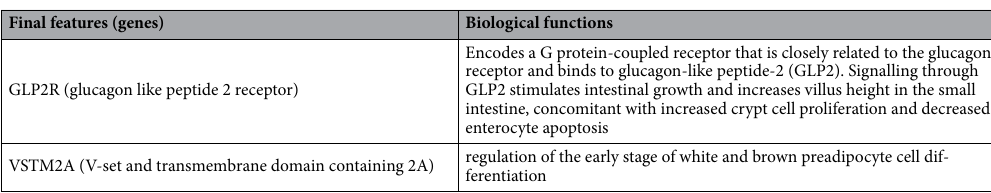
Table 5. Literature analysis for biological function of GLP2R and VSTM2A